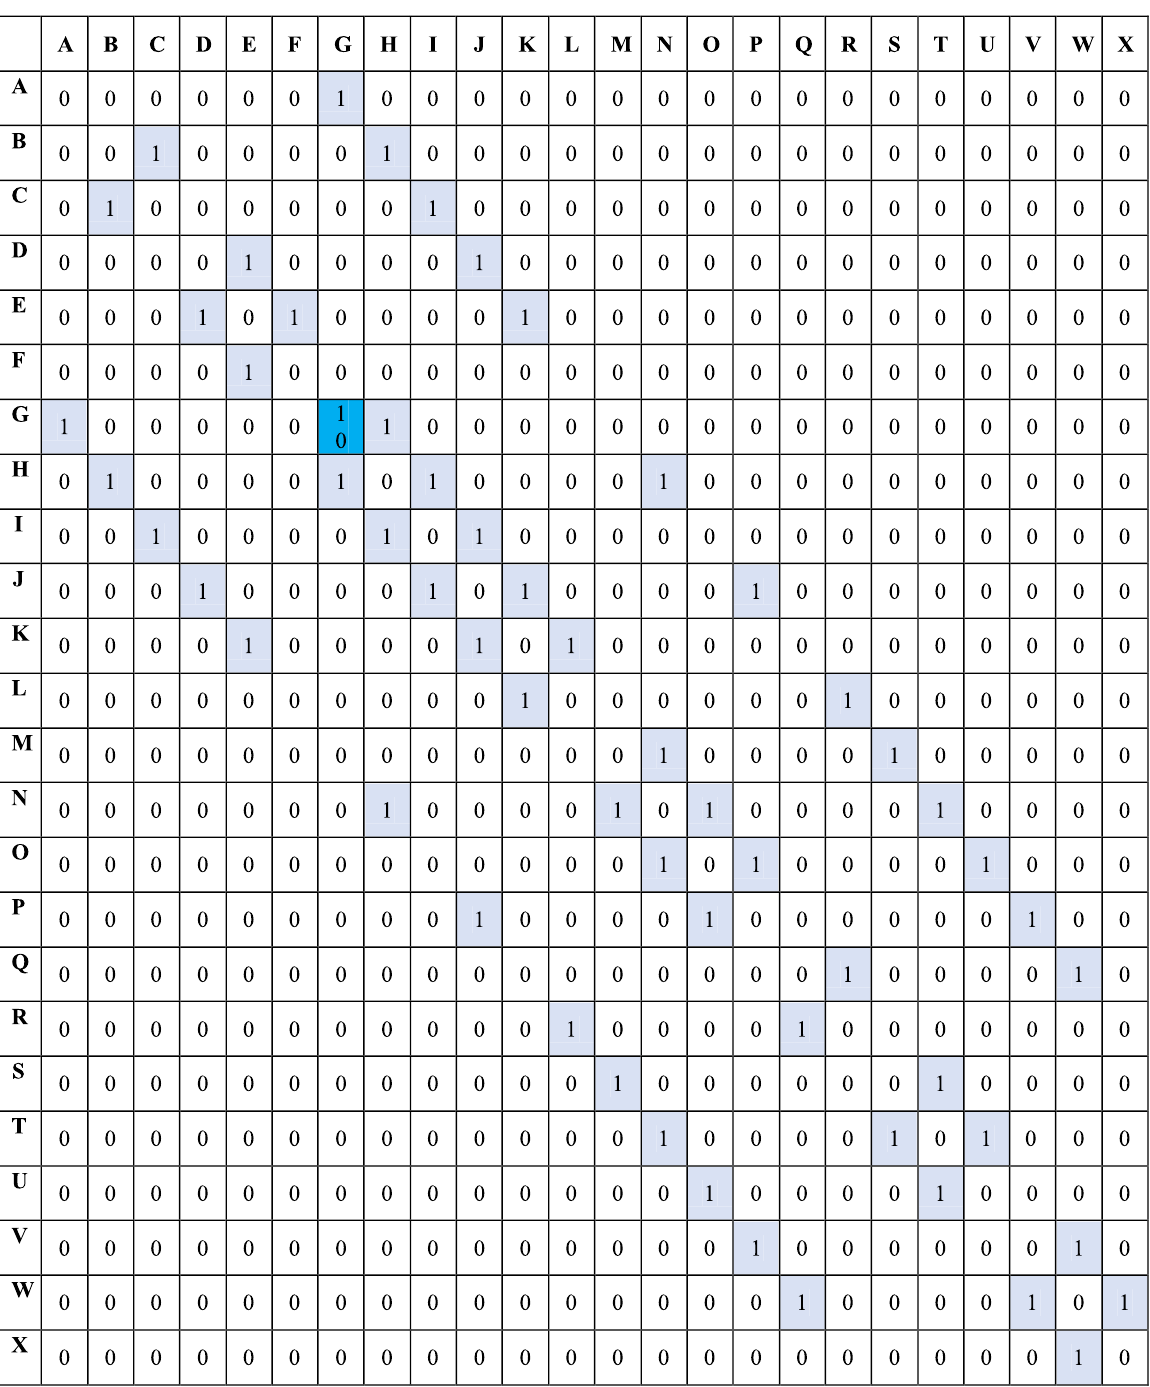
Figure 4. Experimental environment matrix for segment 1 before Q-learning